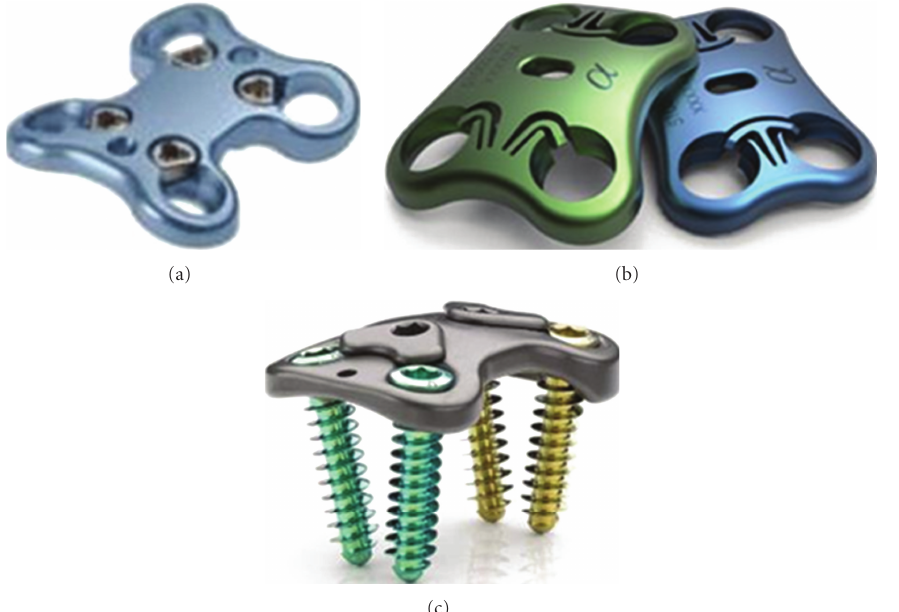
Figure 4: Anterior plate system. (a) Aegis (DePuy, Raynham, MA, USA), (b) Aspida (Alphatec spine, Carlsbad, CA, USA), and (c) Trinica (Zimmer spine, Minneapolis, MN, USA) (website).